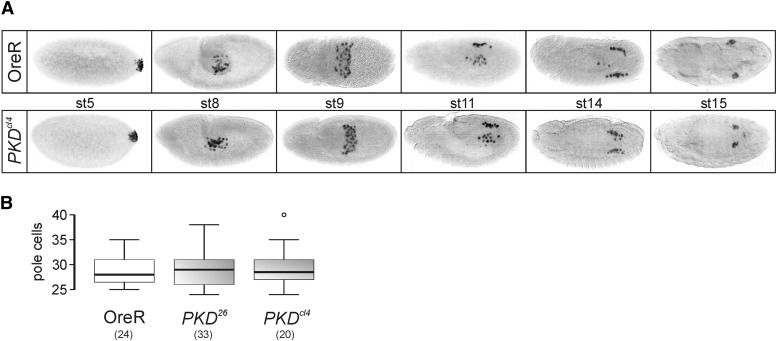
Pole cell migration. (A) Embryos were stained with anti-vasa antibodies to mark the pole cells. Anterior is to the left, embryonic stages are indicated (st5-st15). Pole cells originate at the posterior pole (stage 5), and migrate through the posterior midgut (stage 8) to move posteriorly during the following stages (9-14), before they conglomerate with mesodermal cells (stage 15) to form the round gonadal anlagen in the embryo. No apparent differences are seen between the control Oregon R (OreR, upper row) and PKDcl4 mutants (lower row). (B) Moreover, the number of pole cells was not significantly different between the two PKD alleles, PKD26 and PKDcl4, and the control OreR. Center lines of the BoxPlots show the medians; box limits indicate the 25th and 75th percentiles; whiskers extend 1.5 times the interquartile range; dot represents outlier. Number of data points is given in parentheses for each genotype.